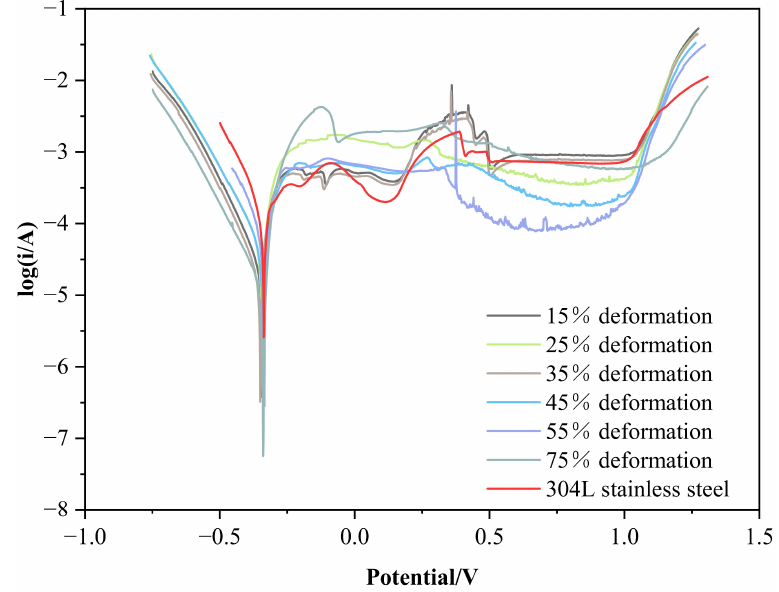
Figure 8. Polarization curve of each specimen in the 5% H 2 SO 4 solution.